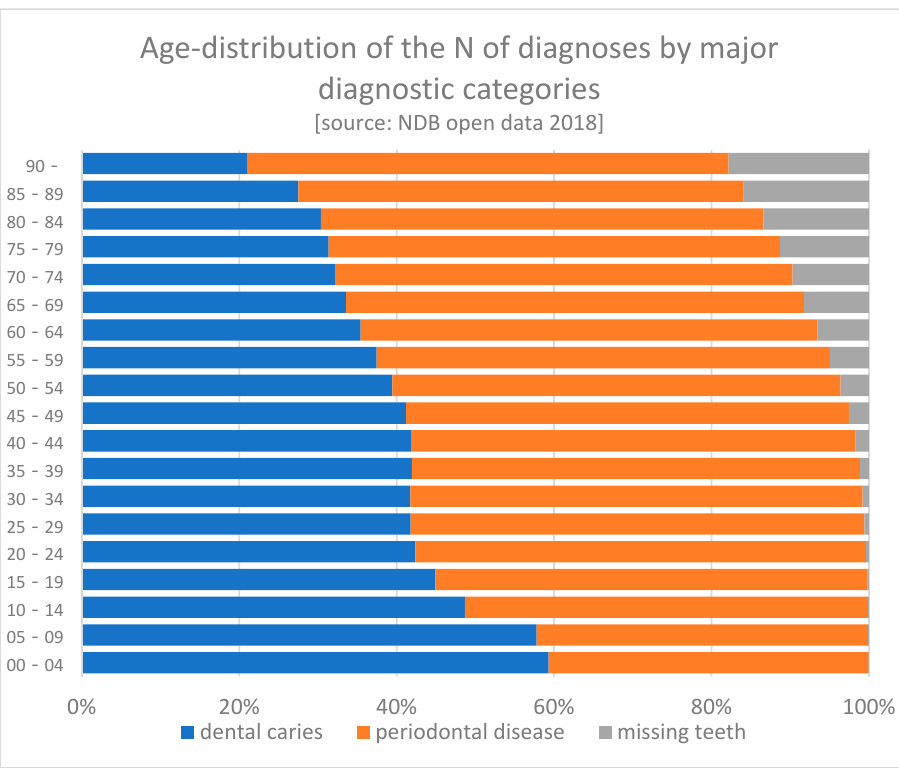
Figure 2. Age distribution of the number of diagnoses by major diagnostic categories. When broken down by ICD10-level diagnoses, two diagnoses (periodontitis and den- Table 6. Ten most common diagnoses of dental claims. tal caries) account for 57.2% of the total number, and the top ten diagnoses account for 82.8% of the total diagnoses (Table 6). Ten Most Common Diagnoses of Dental